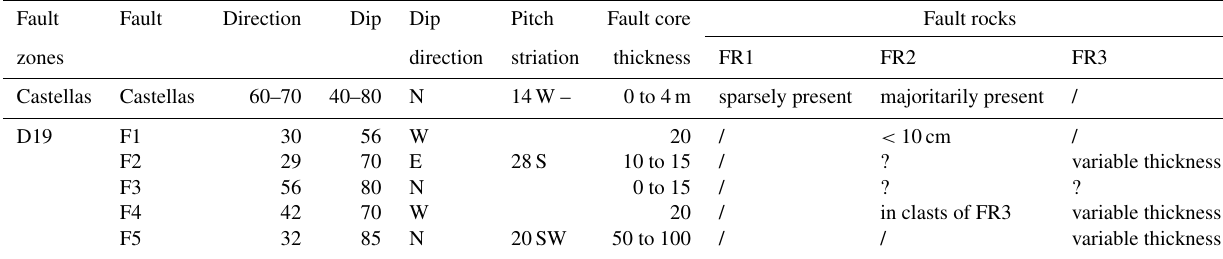
Figure 1. Geological context of the study area. (A) geological map of Provence, (B) Simplified structural map with the location of the Castellas Fault and the stratigraphic column (black dashed line); (C) Stratigraphic column of exposed Cretaceous carbonates (modified from Roche, 2008). Table 1. Structural properties of the fault